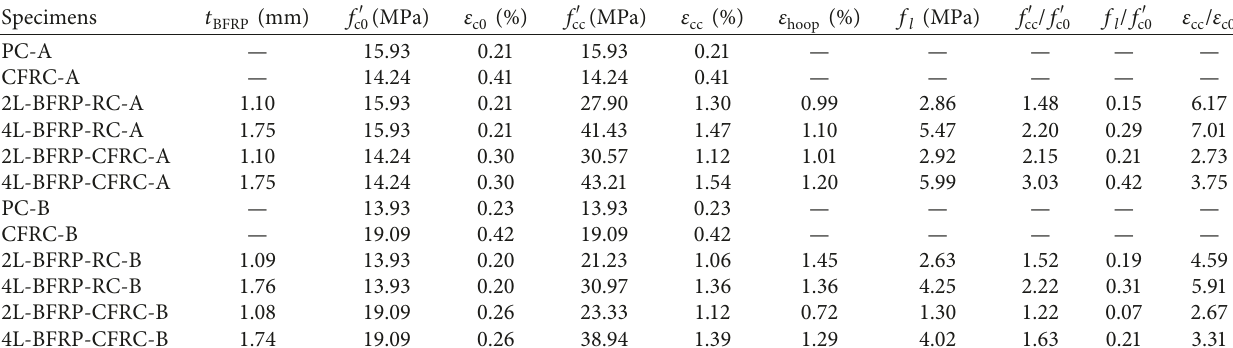
Table 2: Test results of cylinders.